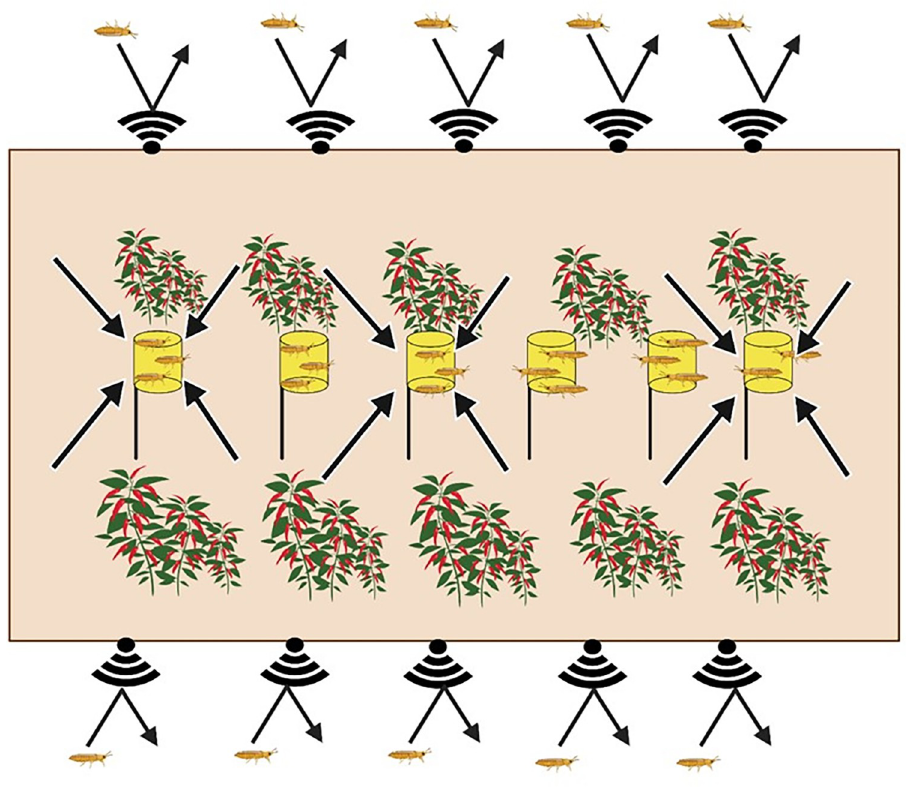
Fig 7. A working model of the push-pull strategy against F . occidentalis using repellent (sound signal logo) and CAN trap (yellow can) in a greenhouse cultivating hot peppers. Arrows indicate the push and pull moving